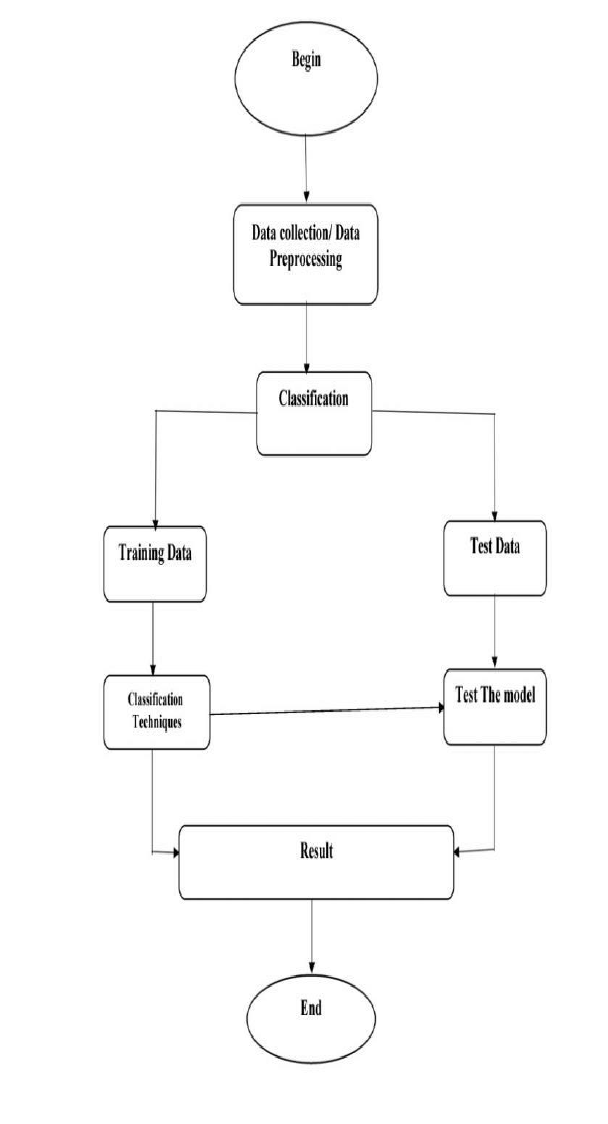
Fig. 2. Work flow of the proposed